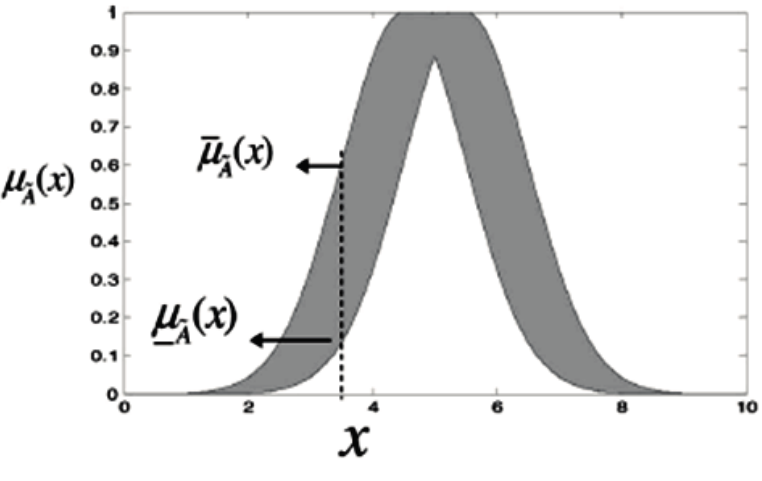
Figure 1. The mean uncertainty on a Gaussian membership.